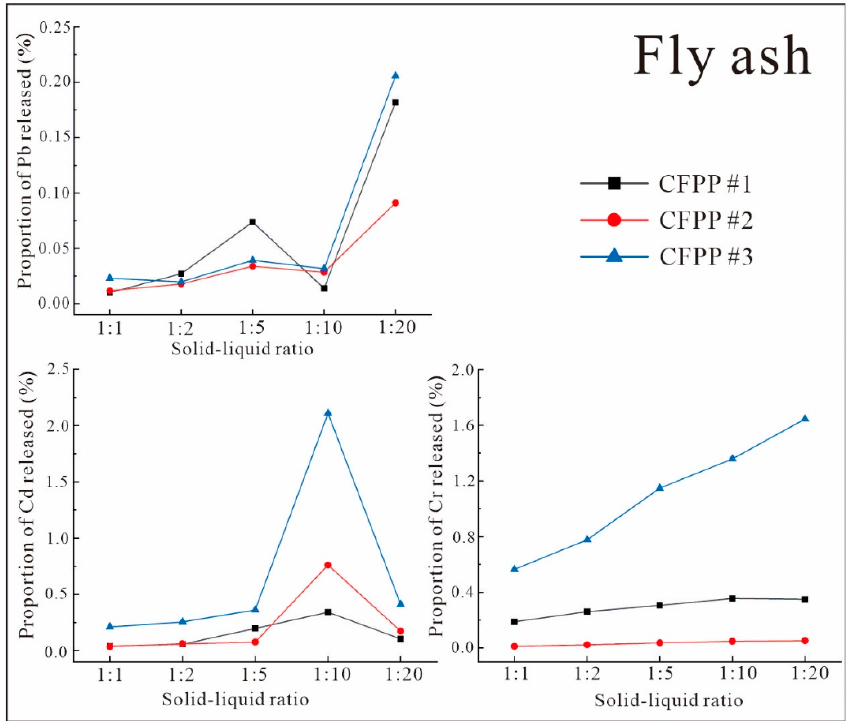
Figure 7. Heavy-metal release fractions from coal FA with various solid-to-liquid ratios.